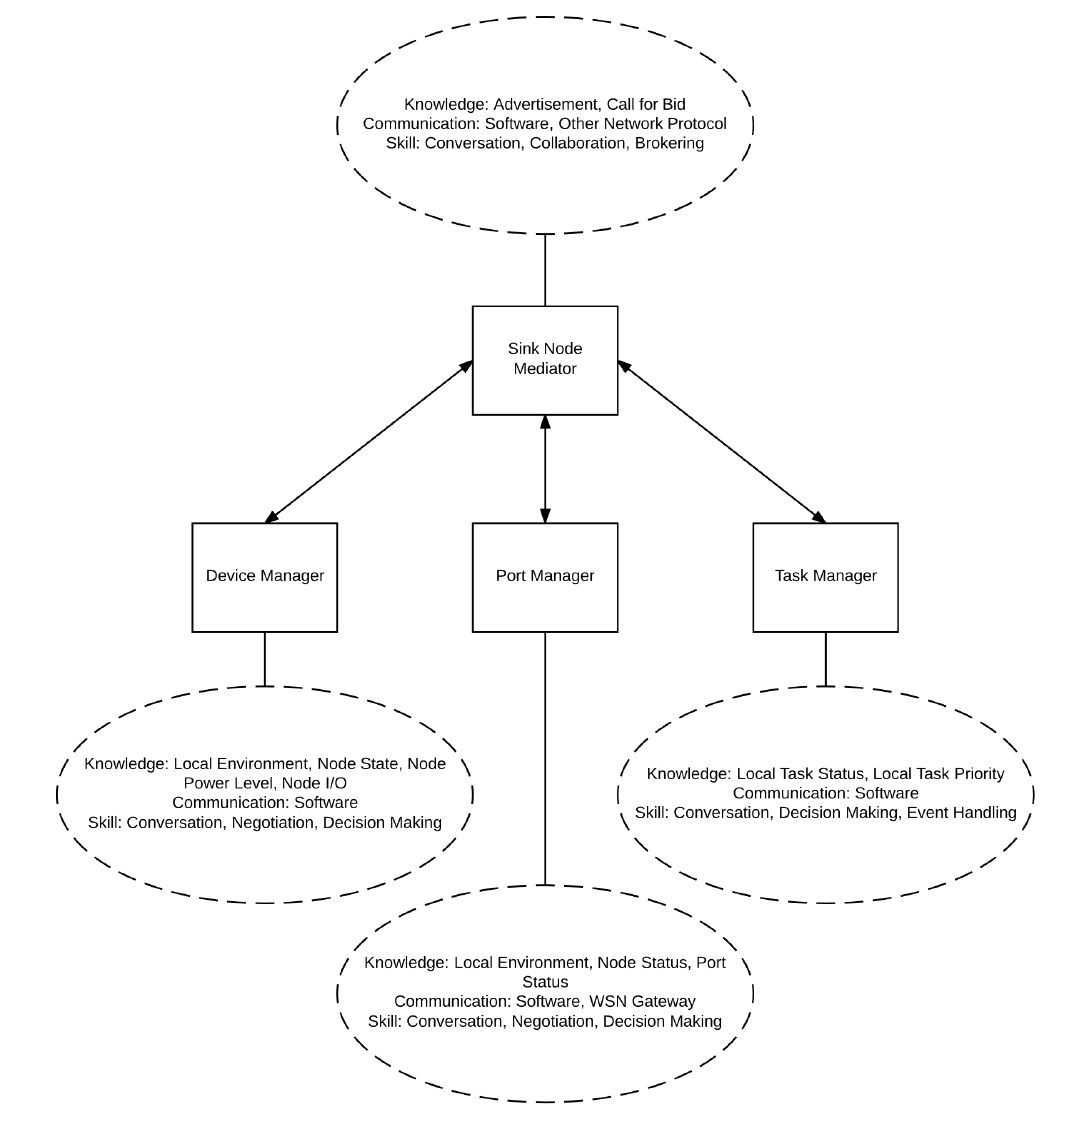
Figure 2. Sink-node embedded agents for agent-based